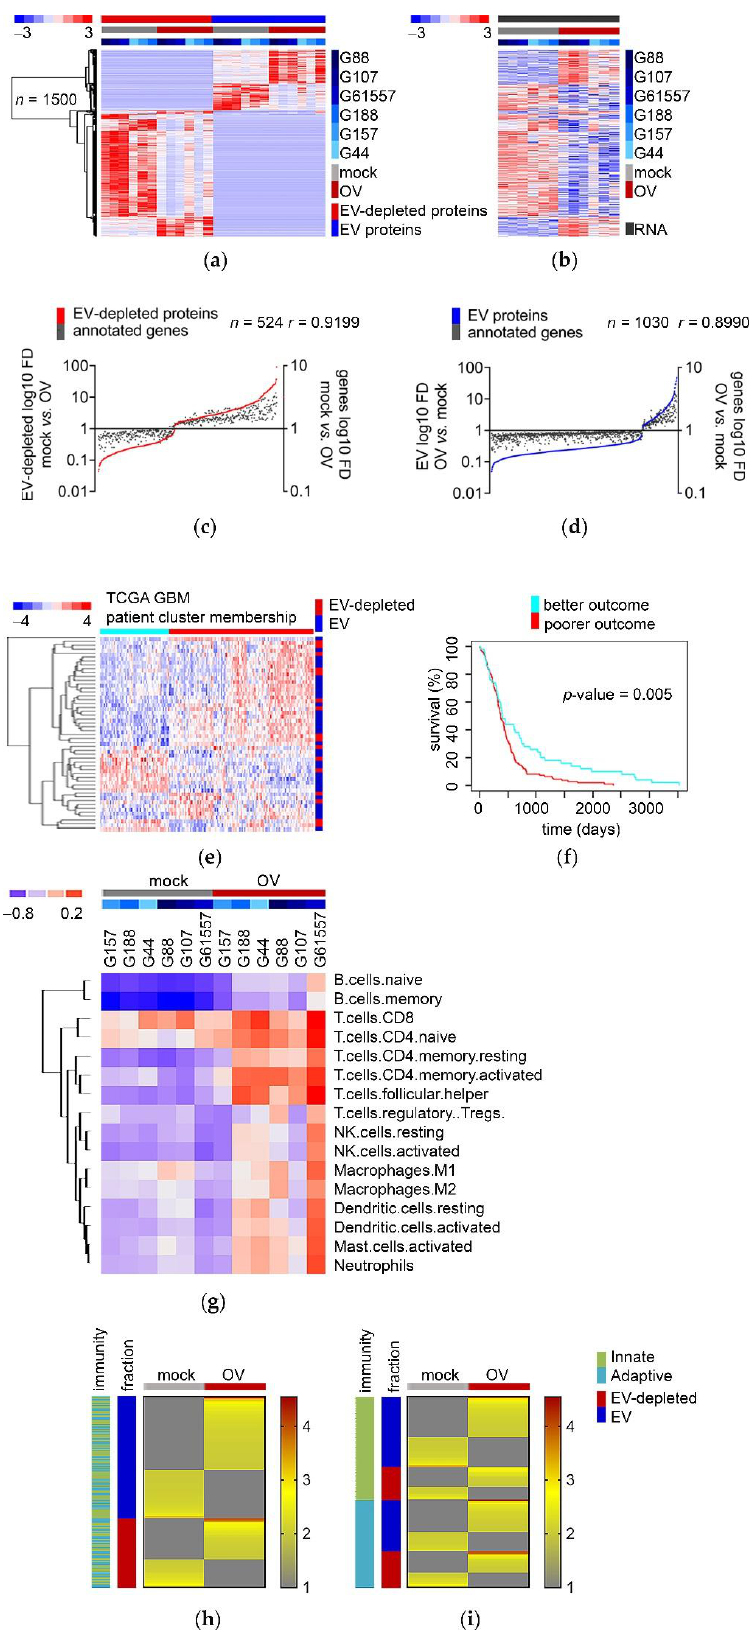
Figure 4. The re-configuration of GSCs’ transcriptome upon OV infection predicts the composition of their “immune mode” secretome. ( a ) OV infection profoundly affects the composition of the